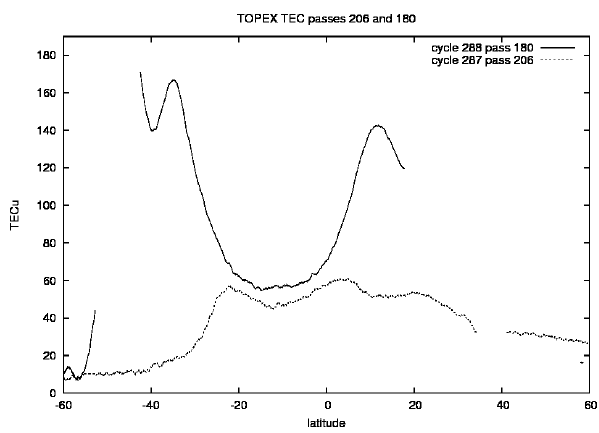
Fig. 3a. Passes 206 (cycle 287 – 6 July 2000) and 180 (cycle 288 – 15 July 2000) of TOPEX as a function of geographic latitude.